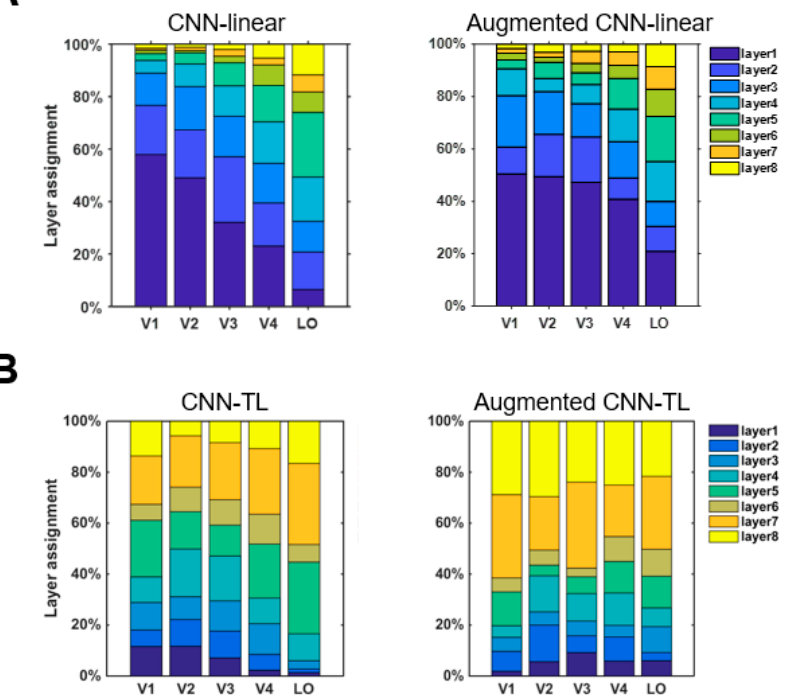
Figure 5. CNN layer preferences of the ventral visual stream in visual encoding models. ( A ) CNN layer preferences of the ventral visual stream in the CNN-linear model and augmented CNN-linear model. The CNN layer preferences of each ROI distribute in a single column. The contribution to the mean prediction accuracy of all voxels in that ROI is shown by colored bars within each column. ( B ) CNN layer preferences of the ventral visual stream in the CNN-TL model and augmented CNN-linear model.